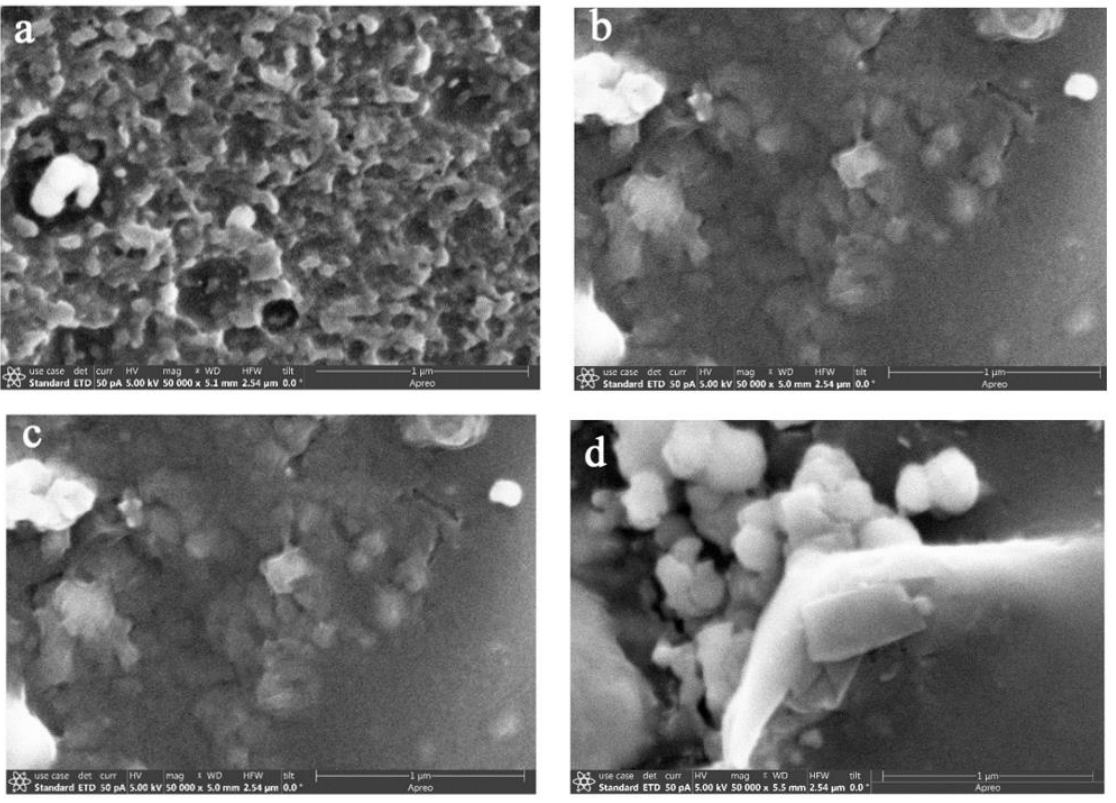
Figure 5. SEM images of the char residues at 900 °C for: ( a ) Neat PI; ( b ) PI-10 wt.% NGS; ( c ) PI-30 wt.% NGS; ( d ) PI-50 wt.% NGS at 50,000x.